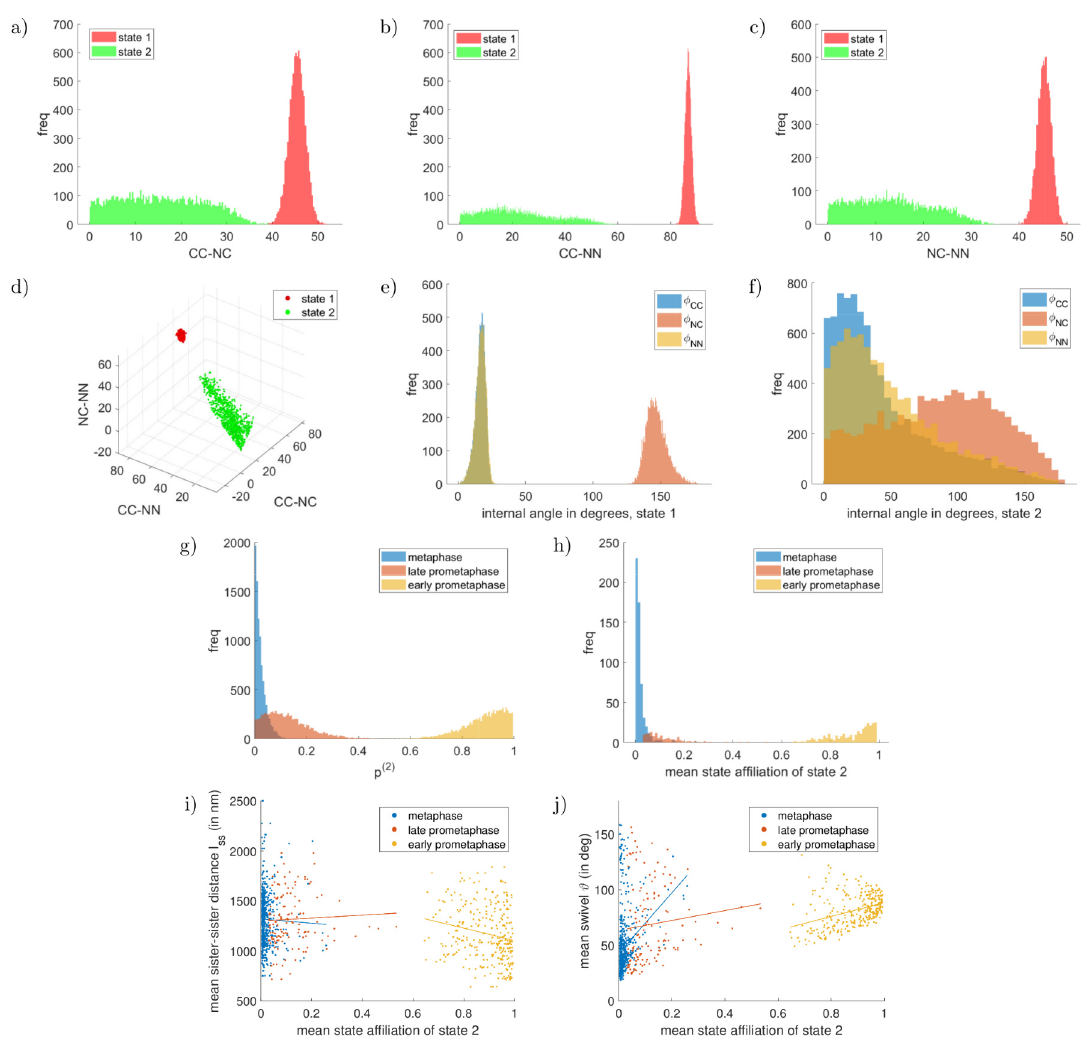
Fig 10. Two-state example for experimental prometaphase-metaphase dataset, Example 4.1. Marginal lengths (in nm) in panels a)– d), the majority state in metaphase is depicted in red, the minority state in green. See supplement Uninformative priors in S1 Text for the joint prior on the lengths. Marginals of the internal angles of the two states are shown in panels e), f). The marginal state proportions of the metaphase-minority state is depicted for each mitotic phase in panel g). The prior on each state proportion is flat in [0, 1]. The mean state affiliations f � z n g for each mitotic phase is shown in panel h), exhibiting clearly separated preferences for kinetochores in n metaphase, late prometaphase and early prometaphase. The shown mean state affiliations are with respect to the natural unattached state, i.e. kinetochores with a value close to one are in the natural unattached state. The bottom row compares the inferred mean state affiliations of each kinetochore with the tension parameters: Panel i) shows the mean sister-sister distance l ss , panel j) the mean swivel ϑ , where the mitotic phase is colour-coded and the straight lines show the best fit linear model for each phase. For significance tests, see Table K in S1